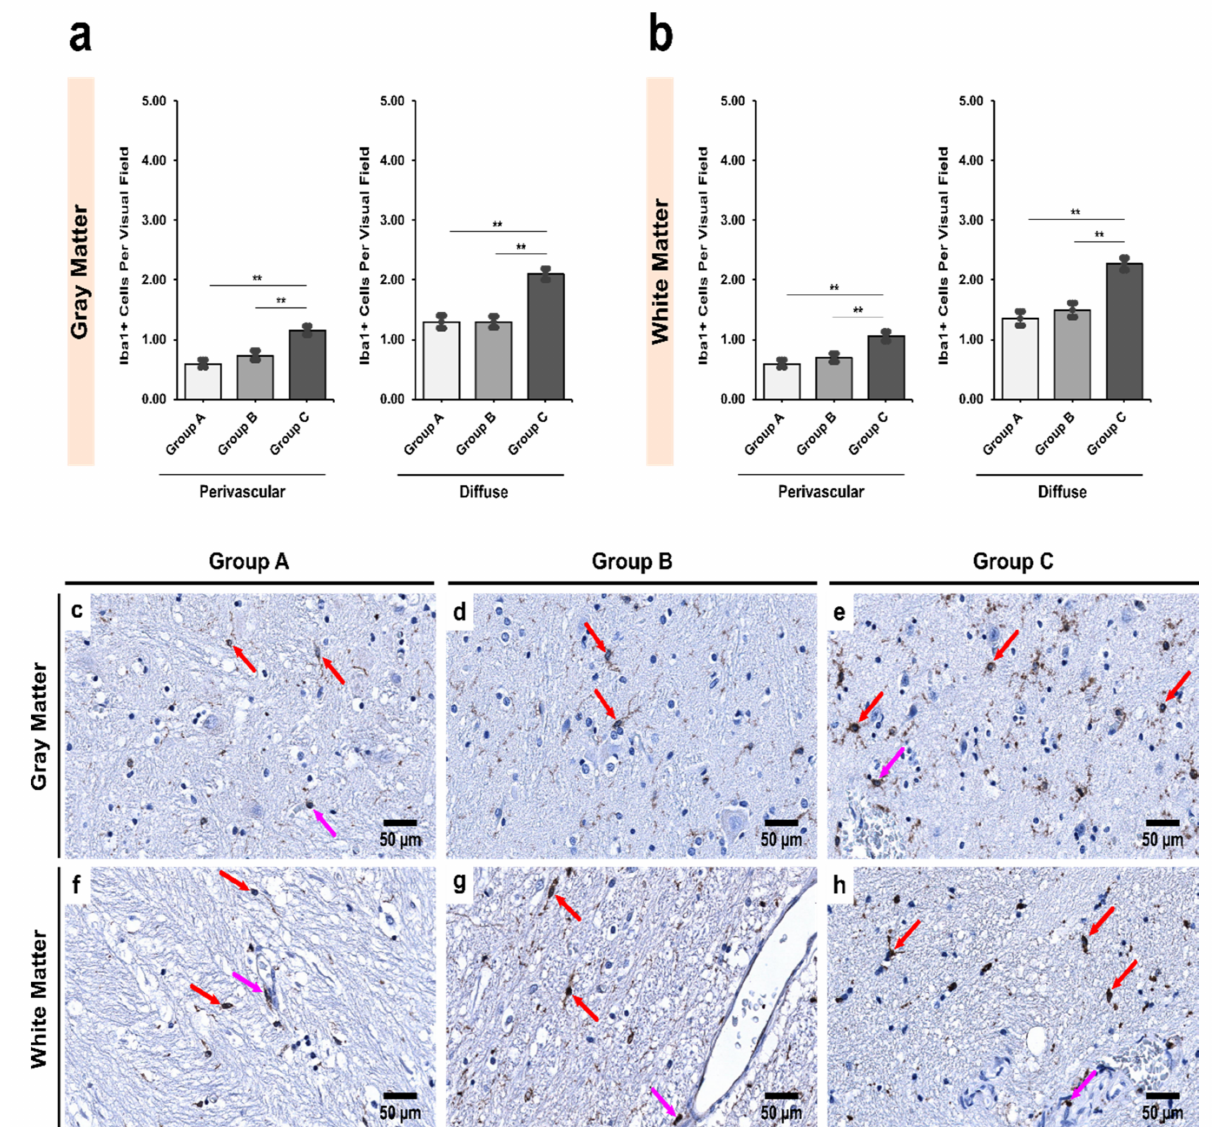
Figure 4. Intergroup analysis of Iba1+ cells per visual field in Pars Reticulata (SNpr) for the three studied groups in both ( a ) gray and ( b ) white matter. The analysis was done for both perivascular and diffuse locations. The bar plots indicate the average number of Iba1+ cells ± S.E. (Standard Error) seen per visual field. ** indicates a significant difference between the groups ( p < 0.05 with Bonferroni correction is considered significant). Distribution of Iba1+ cells per visual field in ( c , f ) Group A (controls); ( d , g ) Group B (age-matched alcoholics) and ( e , h ) Group C (non-age-matched alcoholics). Pink arrows indicate perivascular Iba1+ cells while red arrows indicate diffuse Iba1+ cells. Original magnification, 400 × . Scale bars, 50 µ